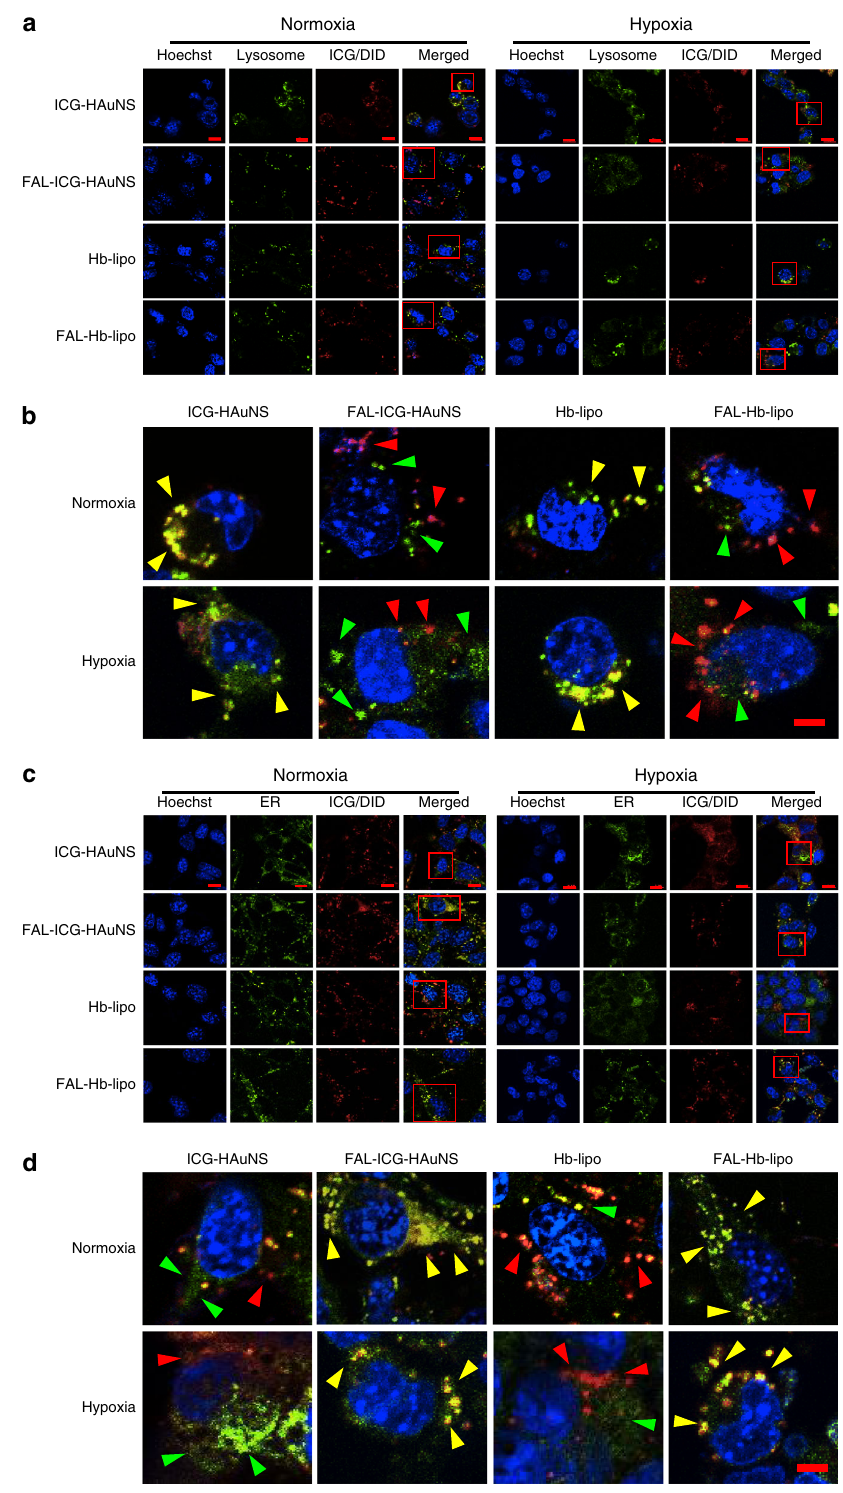
Fig. 2 Lysosome and endoplasmic reticulum (ER) co-localization. a Representative fl uorescent images of lysosomal co-localization of ICG-HAuNS, FAL- ICG-HAuNS, Hb-lipo, or FAL-Hb-lipo under normoxia and hypoxia, respectively. Scale bars, 10 μ m, n = 3. b Enlarged images of a (red boxes). Yellow arrows indicate “ merge ” ; green arrows indicate “ lysosome ” ; red arrows indicate “ ICG/DID ” . Scale bars, 5 μ m, n = 3. c Representative fl uorescent images of ER co- localization of ICG-HAuNS, FAL-ICG-HAuNS, Hb-lipo, or FAL-Hb-lipo under normoxia and hypoxia, respectively. Scale bars, 10 μ m, n = 3. d Enlarged images of c (red boxes). Yellow arrows indicate “ merge ” ; green arrows indicate “ ER ” ; red arrows indicate “ ICG/DID ” . Scale bars, 5 μ m, n =